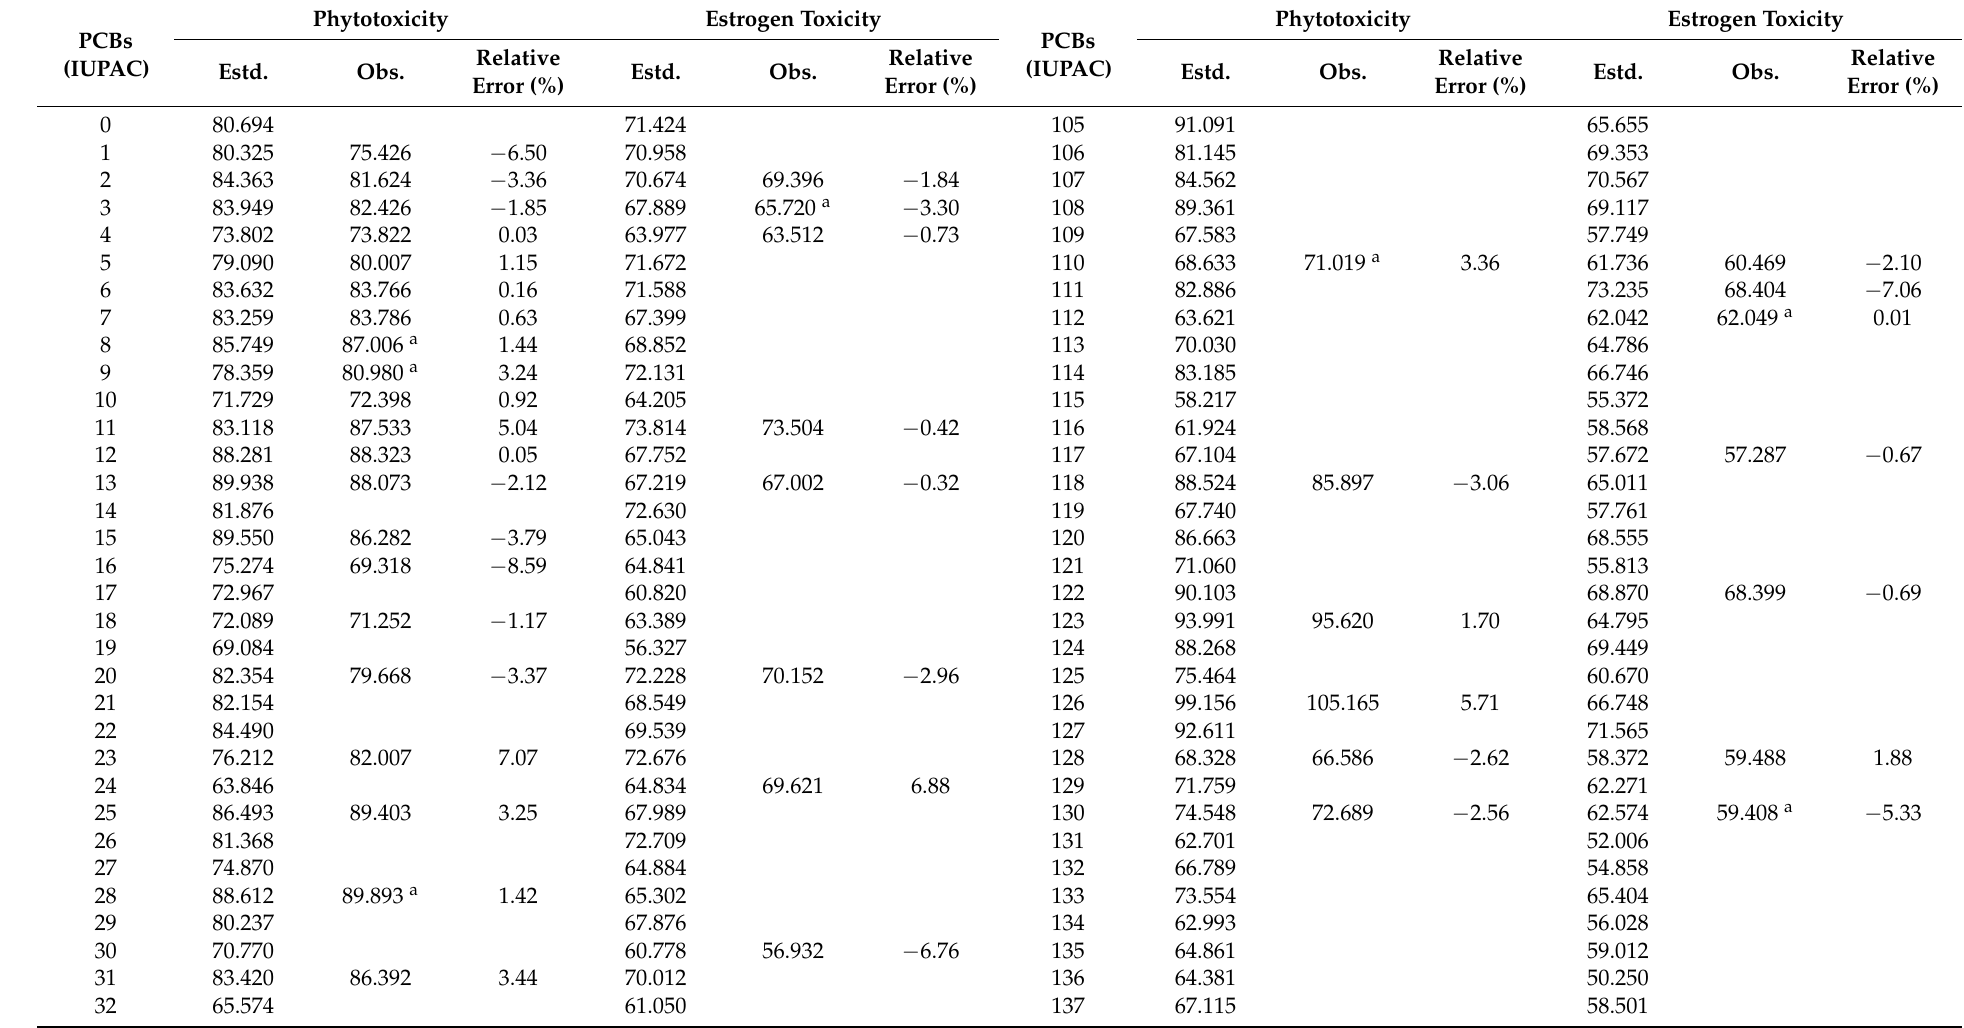
Table 2. Estimated phytotoxicity and estrogen interference values of the PCBs by using the 3D-QSAR